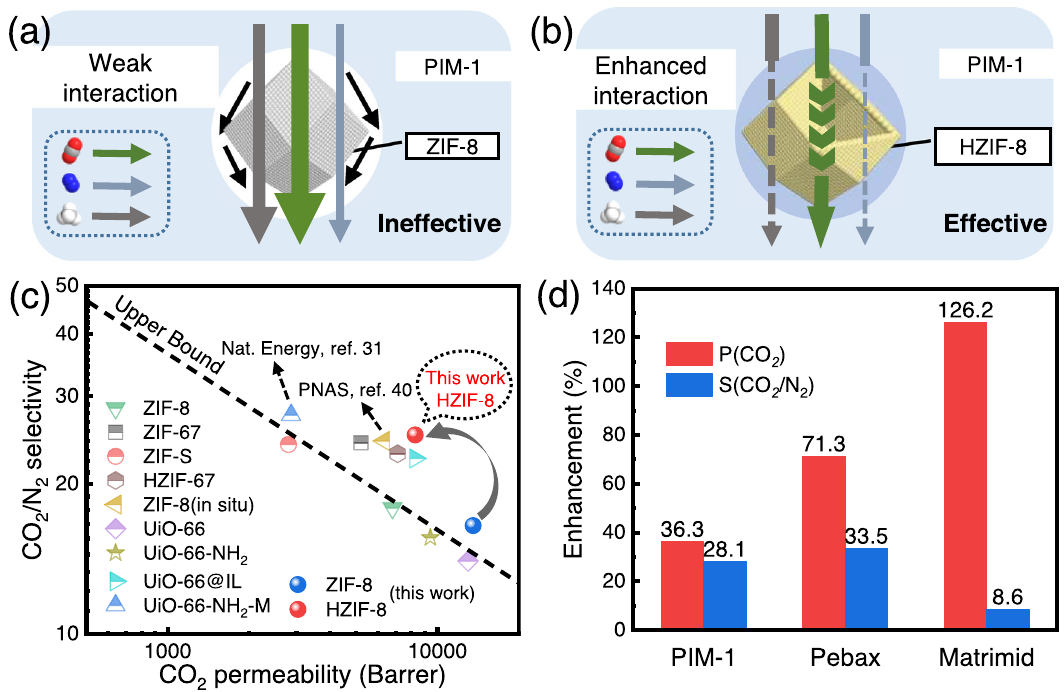
Fig. 4 | Mechanism and superiority of the polyphenol-soldering strategy. a , b Gas-transport mechanism in PIM-1/ZIF-8 ( a ) and PIM-1/HZIF-8 ( b ) MMMs. The gas molecules in the dotted box represent CO 2 , N 2 , and CH 4 from top to bottom; c Comparison of CO 2 /N 2 separation performance obtained in this work with other reported PIM-1/MOF MMMs. Detailed comparison data are available in